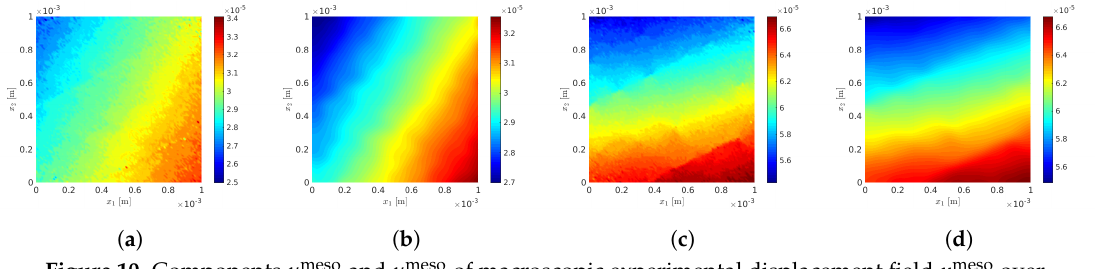
Figure 10. Components u meso and u meso of macroscopic experimental displacement field u meso exp over exp,2 exp,1 the 2D mesoscopic domain Ω meso exp before and after application of the Gaussian spatial filter. ( a ) u meso unfiltered; ( b ) u meso filtered; ( c ) u meso unfiltered; ( d ) u meso exp,2 exp,2 exp,1